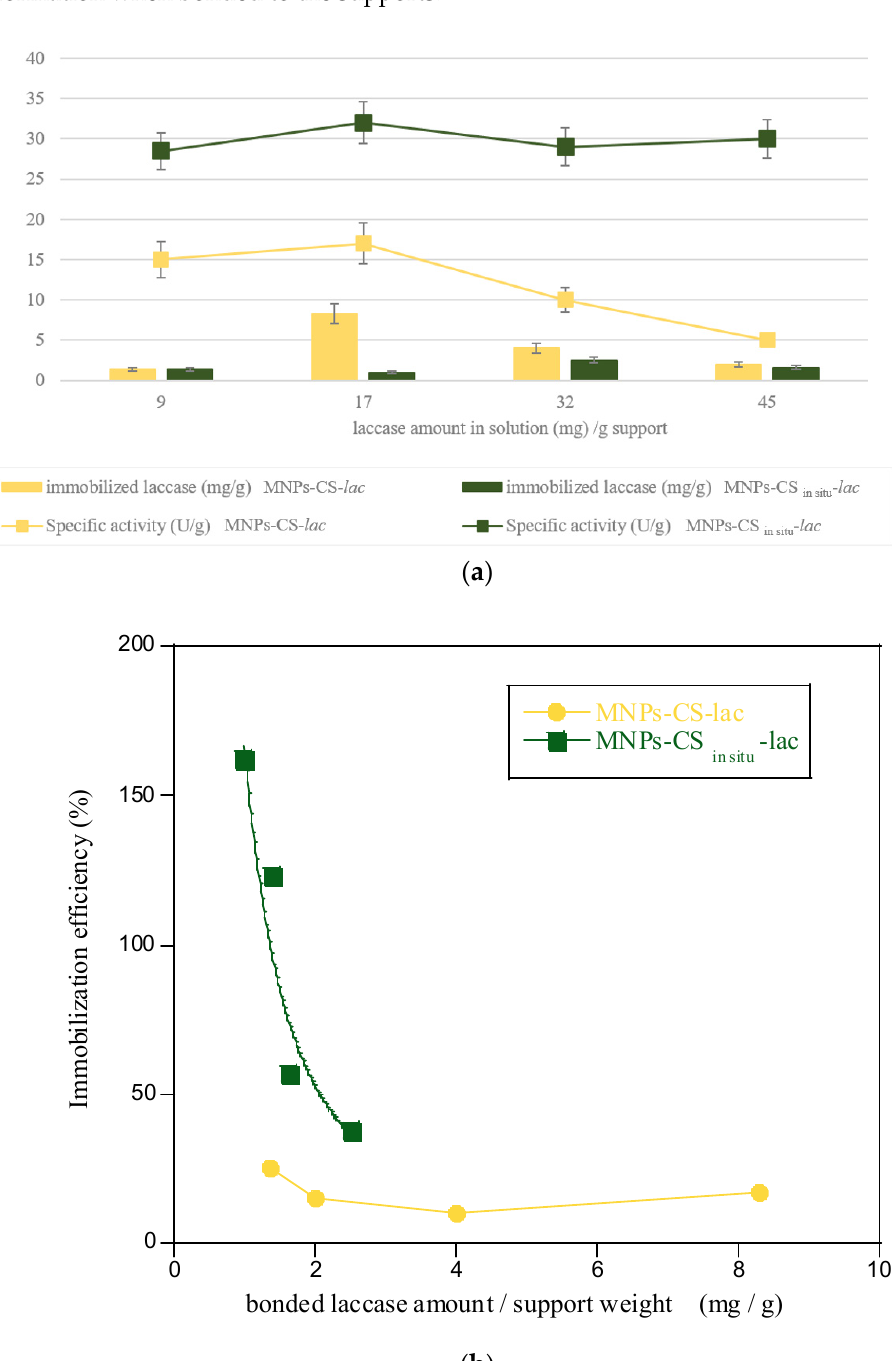
Figure 4. Immobilized laccase onto magnetic systems in the function of enzyme amount in solution normalized per support weight and respective specific activities ( a ); immobilization efficiency vs. laccase amount bonded onto magnetic systems ( b ).